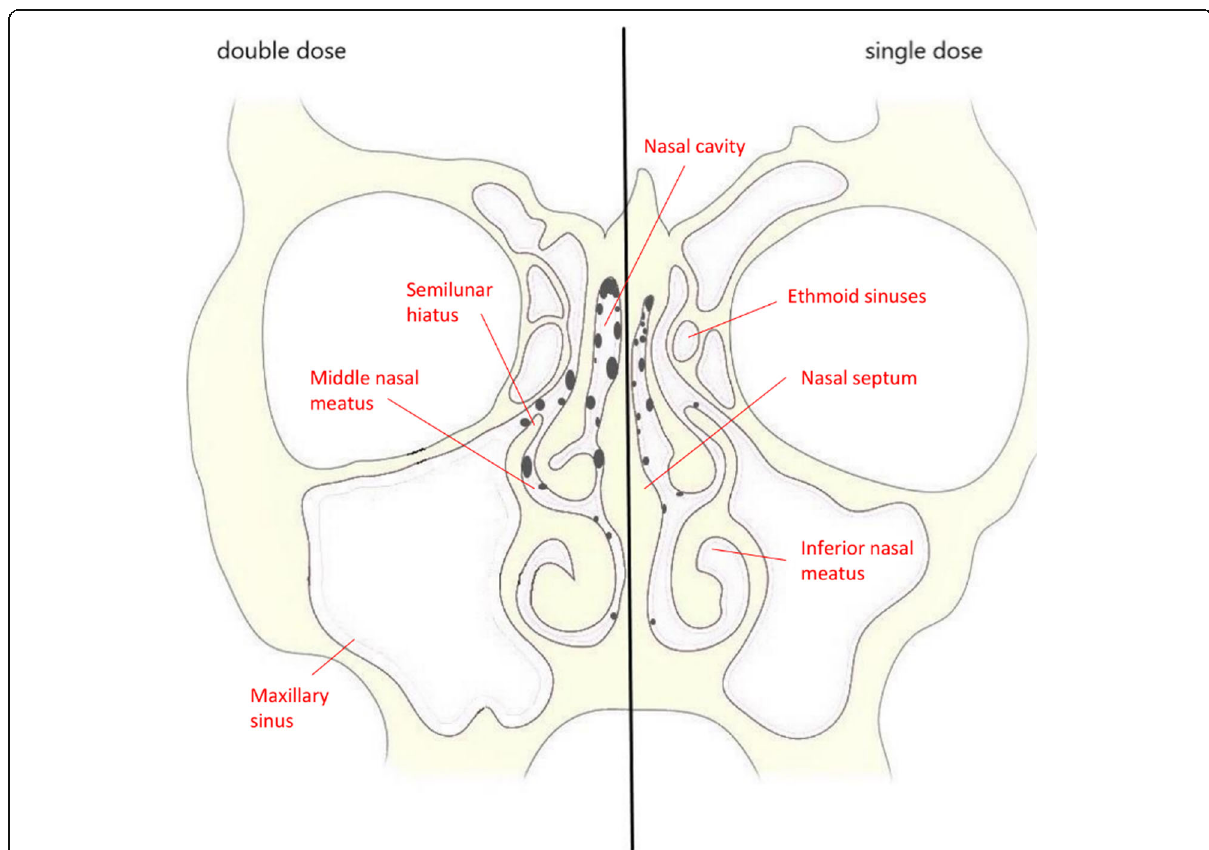
Fig. 2 Coronal projection diagram of the distribution of droplets within the nasal cavity. The left side shows the distribution pattern after nasal application of the double dose (two single applications in rapid succession) while the right sides represent a single dose application. The distribution of droplets from different coronal slices (including both single and double dose scans) was projected onto a single coronal slice. Droplets are indicated as dark spots. The droplets ’ size is an accurate representation of their relative size in comparison to the underlying anatomical structures. Note the presence of droplets predominantly in the superior and middle nasal meatus and for the double dose in the regions of the semilunar